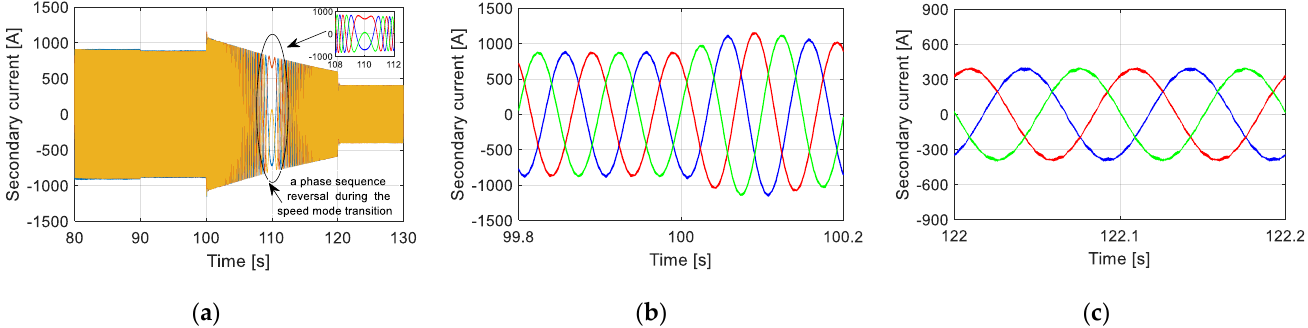
Figure 19. ( a ) Active power response to reference-speed-dependent load variations ( Target II ); ( b ) electromagnetic torque ( Target III ); ( c ) primary reactive power ( Target III ).